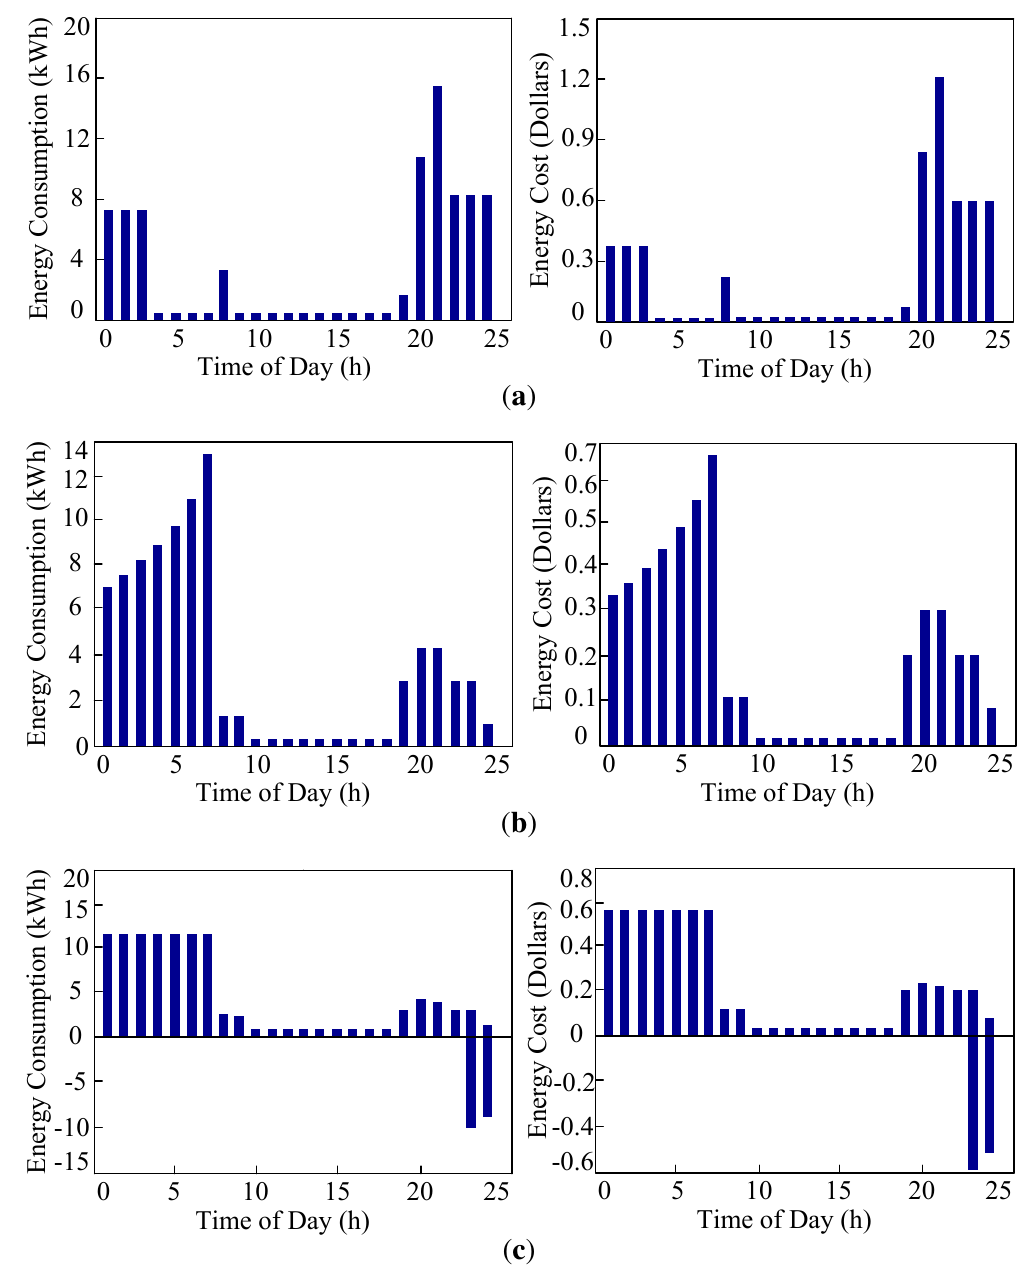
Figure 3. Scheduled energy consumption and corresponding cost of the aggregate five users having household appliances and plug-in electric vehicles. ( a ) No ECS; ( b ) ECS without PEV discharging; ( c ) ECS with PEV